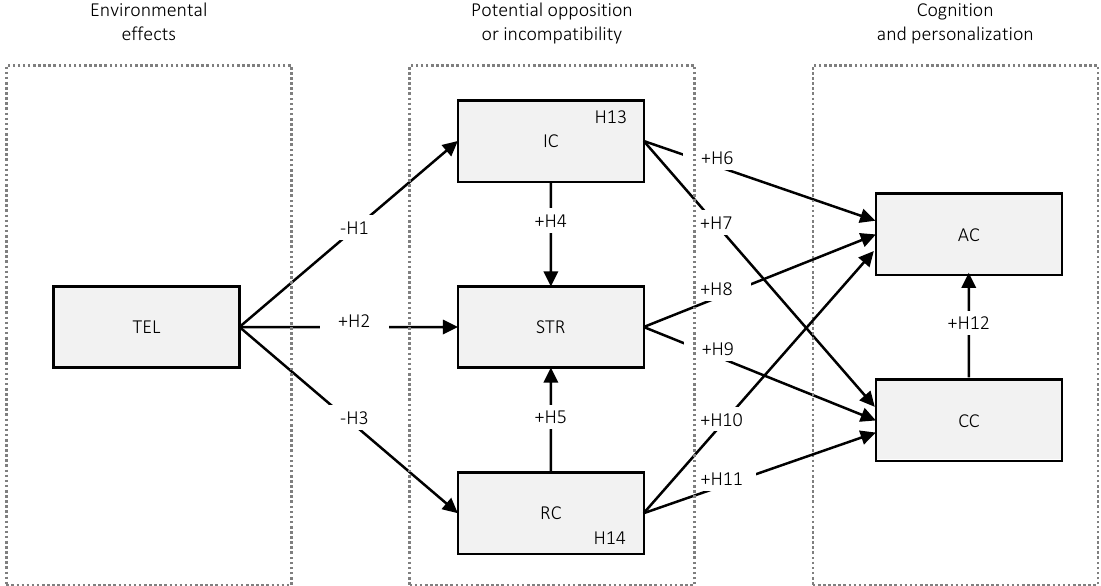
Figure 1. Conceptual